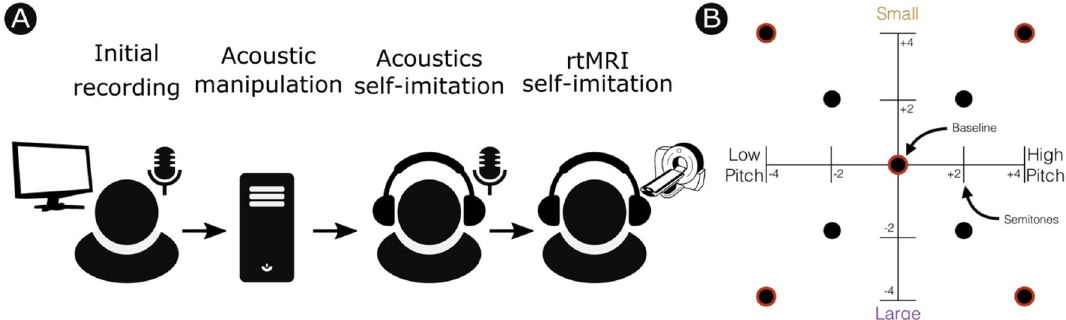
Figure 1. ( A ) Overview of methodology for experiment 1. Participants were first recorded producing the carrier words BEAD and BARD. These recordings were acoustically manipulated to have higher or lower vocal pitch, and narrower or wider formant spacing to imply a smaller or larger body size. Participants then imitated the manipulated recordings separately in a sound attenuated booth to produce audio recordings suitable for acoustical analyses, and again in an MRI scanner for vocal tract imaging. ( B ) Summary of acoustic manipulations. The self-imitation for acoustics session included all conditions shown (± 2 or 4 semitones). The self-imitation for rtMRI session included only the conditions outlines in red (± 4